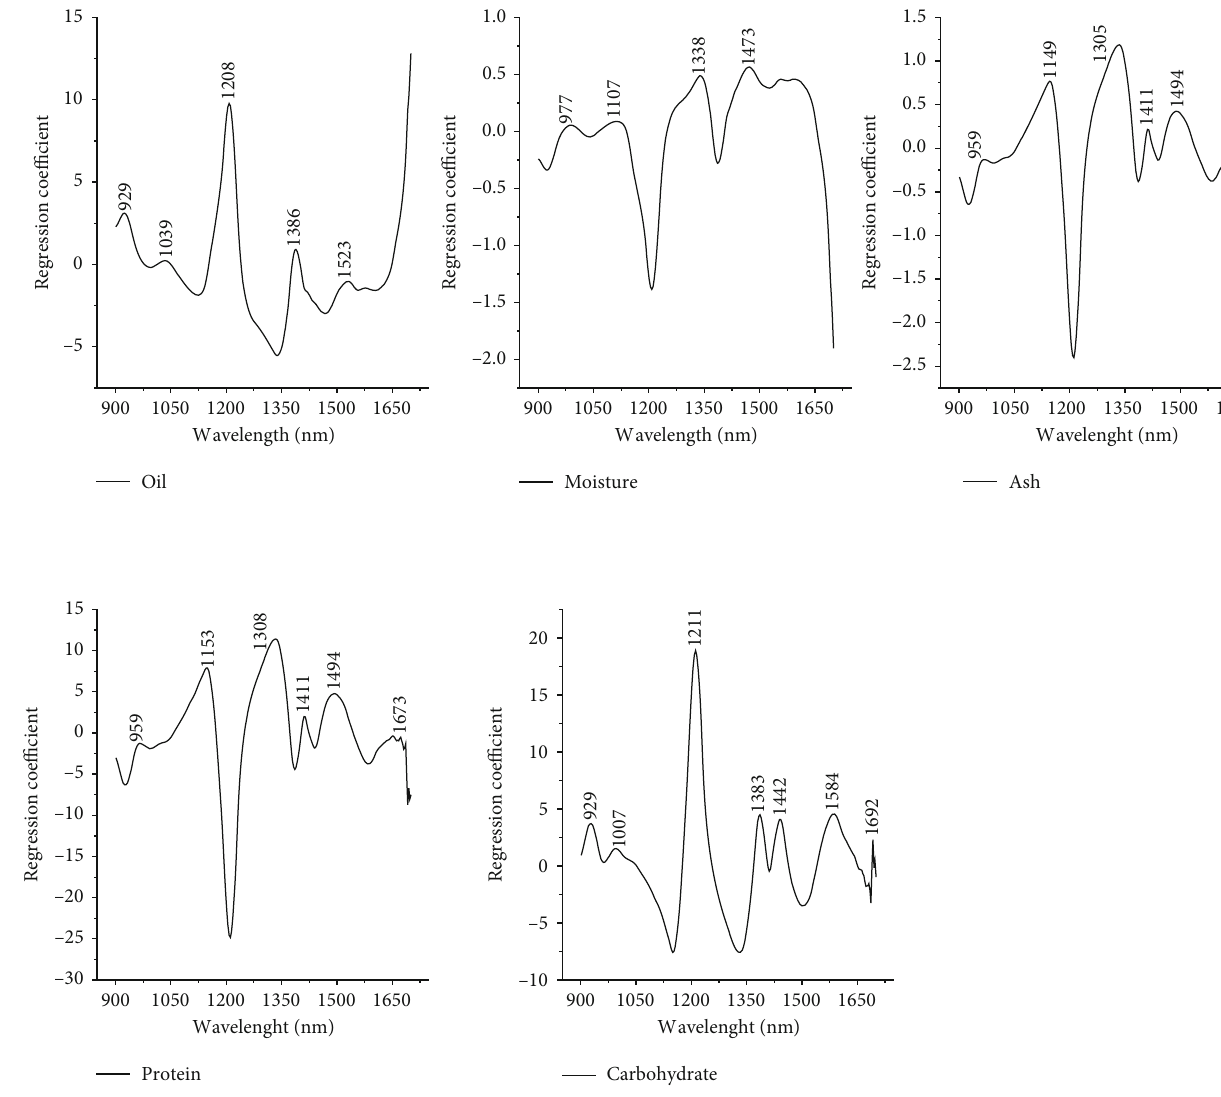
Figure 3: The regression coe ffi cient of nutrients by NIR